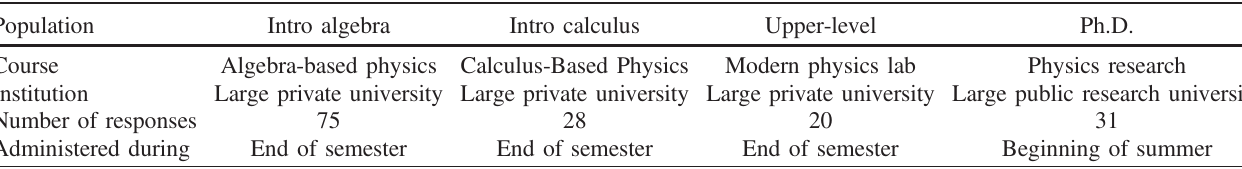
TABLE II. Information of survey